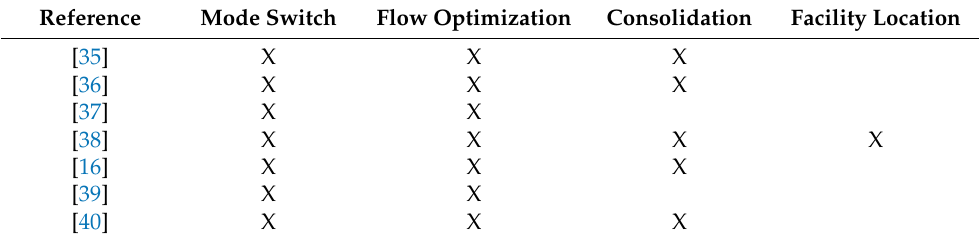
Table 3. Related work with regard to strategic decisions.